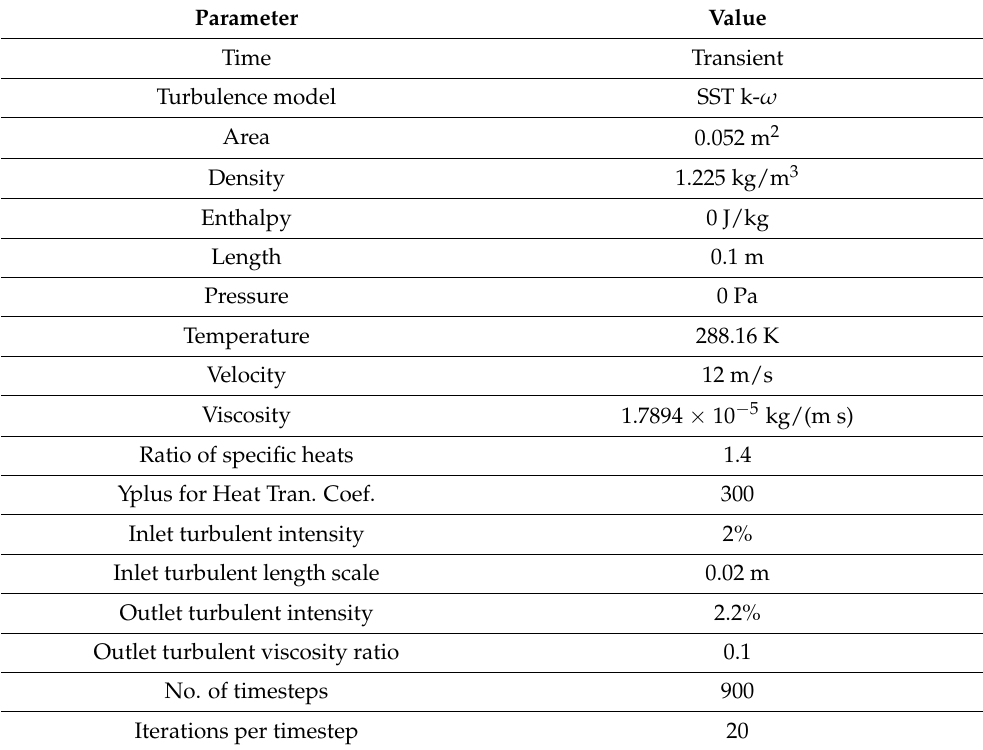
Table 3. VAWT solver